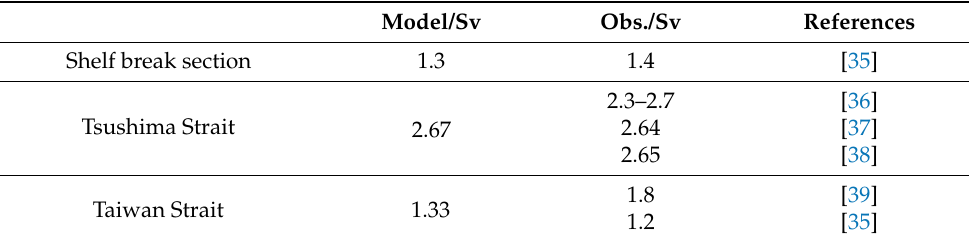
Table 1. Comparison of long-term averaged transport through the SBS, TAS, and TUS observed in previous studies and modelled by the JCOPE2M.